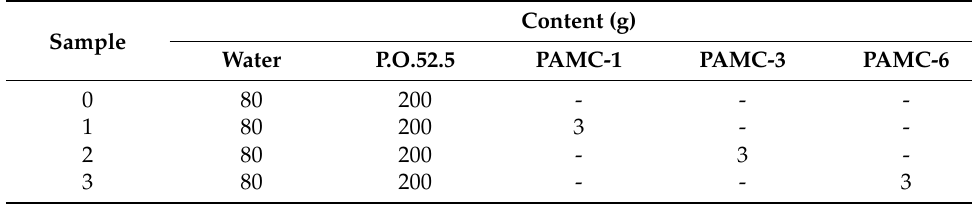
Table 2. Specific ratios of concrete samples.